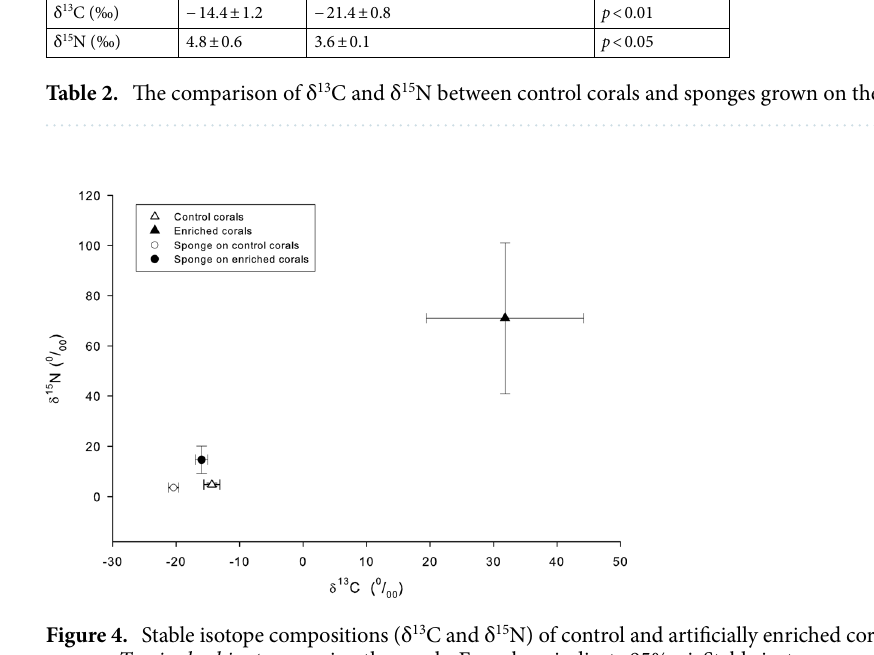
Figure 4. Stable isotope compositions (δ 13 C and δ 15 N) of control and artificially enriched corals and the sponge, Terpios hoshinota, covering the corals. Error bars indicate 95% c.i. Stable isotope composition of T. hoshinota covering enriched corals are significantly higher than those covering control corals (δ 13 C: n = 3,